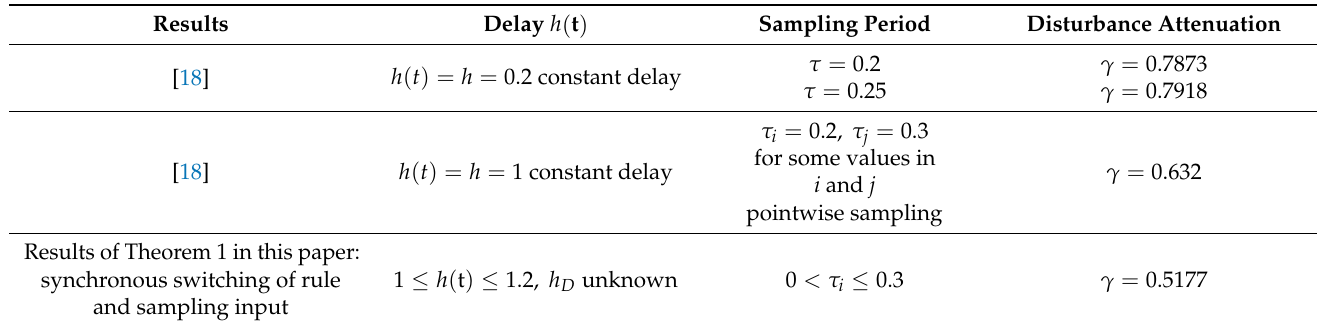
Table 1. Comparison of the obtained results with published